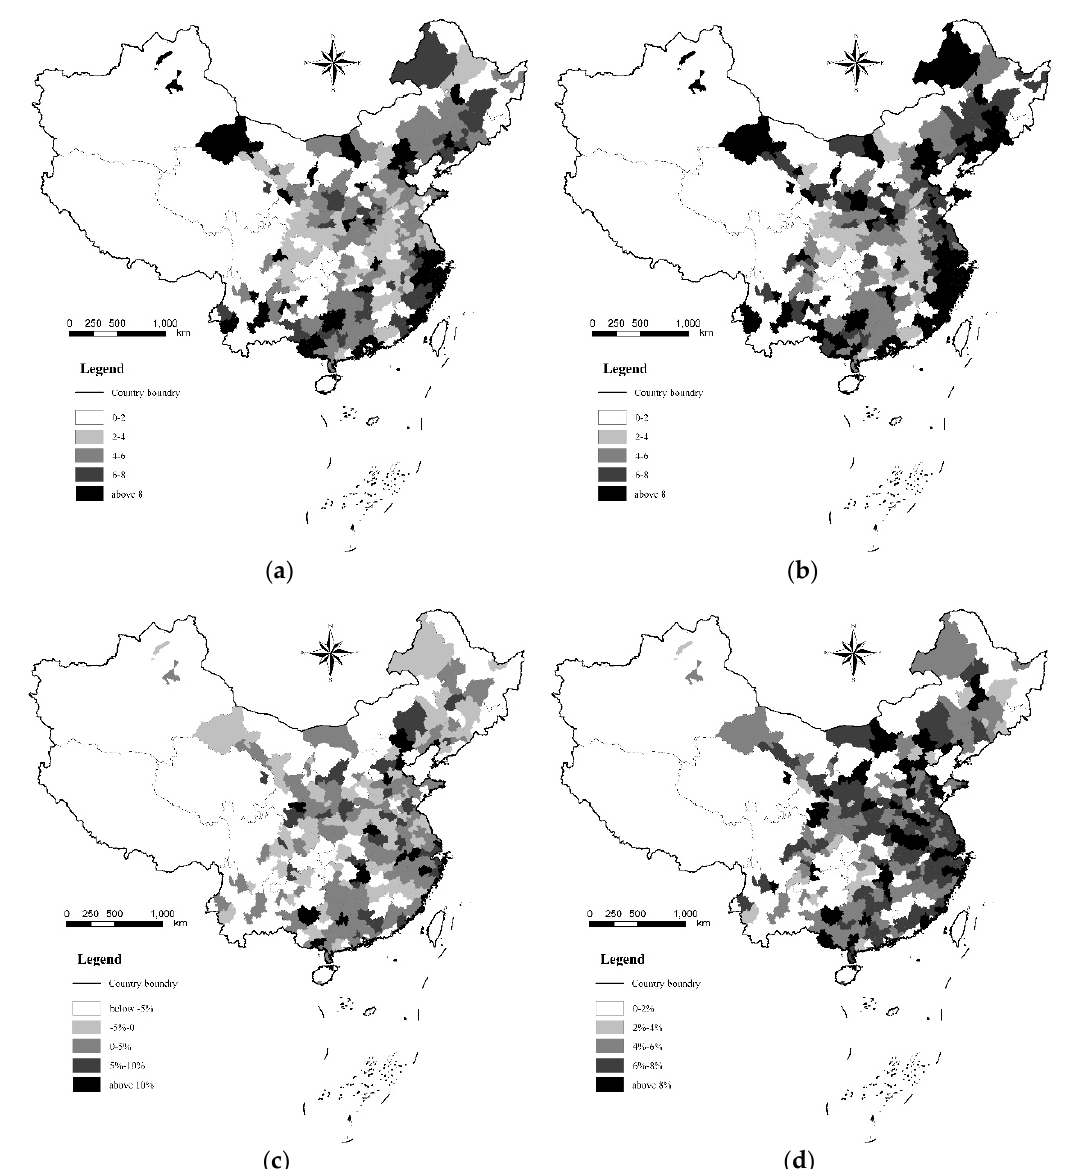
Figure 3. The crime rate of Chinese cities (2000–2013). ( a ) Average arrest rate; ( b ) Average prosecution rate; ( c ) Annual change in arrest rate; ( d ) Annual change in prosecution rate.